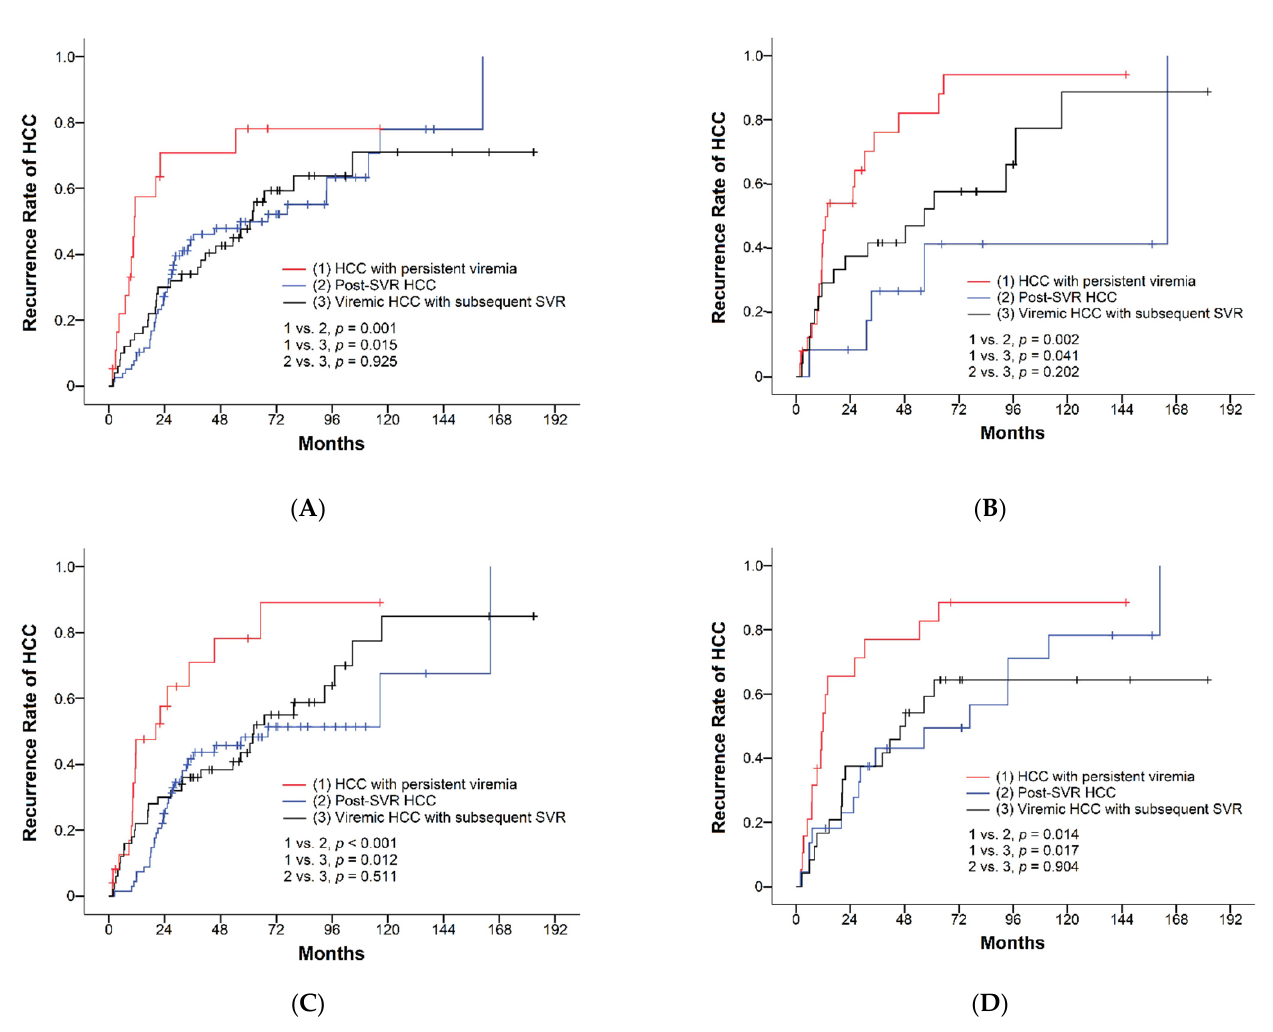
Figure 3. Comparisons of recurrence rates of HCC based on viral status in patients with ( A ) ALBI grade I, ( B ) ALBI grade II/III, ( C ) non-LC, and ( D )